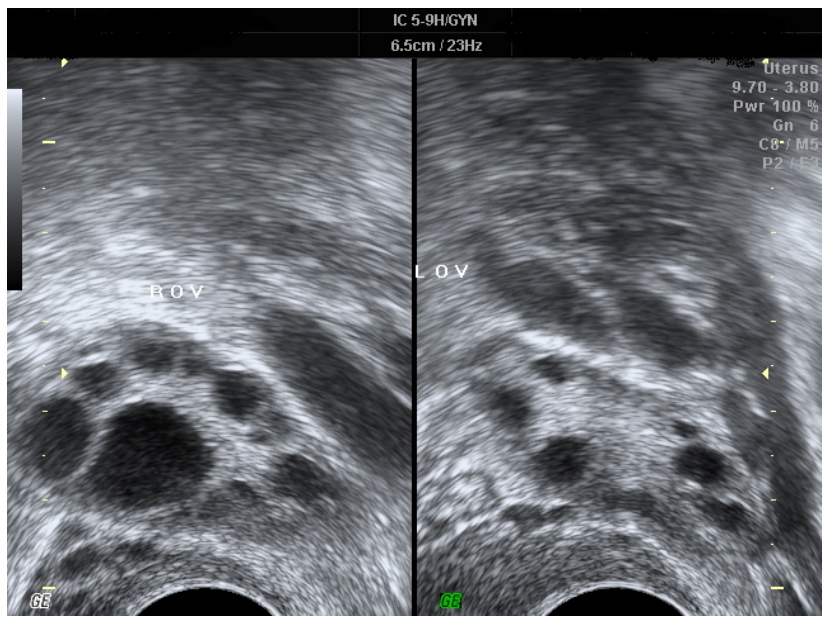
Figure 1. The ultrasonic images of PCOS, which are characterized by the presence of multiple small “necklace-like” follicles in both ovaries and/or increased ovarian